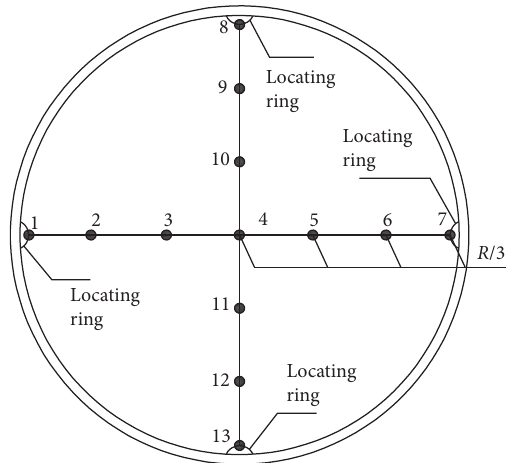
Figure 3: Layout of the measuring points.